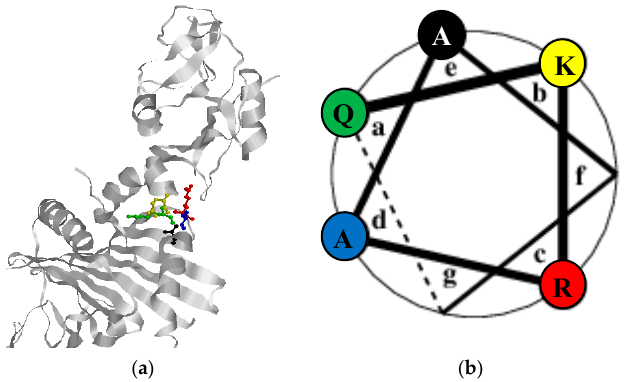
Figure 1. Structure analysis of the shared epitope motif in the HLA-DR1-gp42 complex. ( a ) The SE motif (amino acids 70–71) is located in an α -helix structure. The individual amino acids and their orientation is visualized by the following colors Q70 (green), K71 (yellow), R72 (red), A73 (blue), A74 black. A, K, Q, R represent the amino acids Ala, Lys, Gln and Arg. ( b ) Helical wheel of the SE motif. The left side of the wheel faces the peptide groove, the right side is on the “outside” of the helix. The heptad positions of the helix are labeled a–g, by convention.